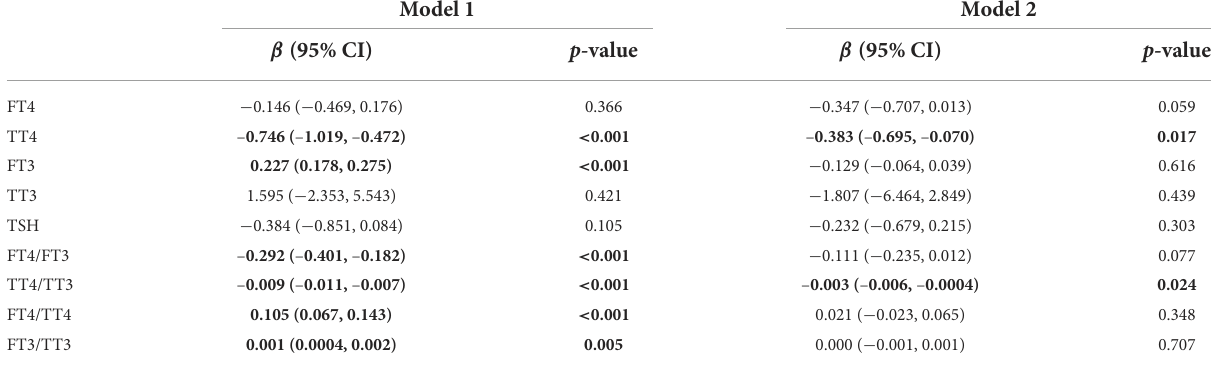
TABLE 2 Association between dietary selenium intake and serum thyroid hormones in U.S. adults in NHANES